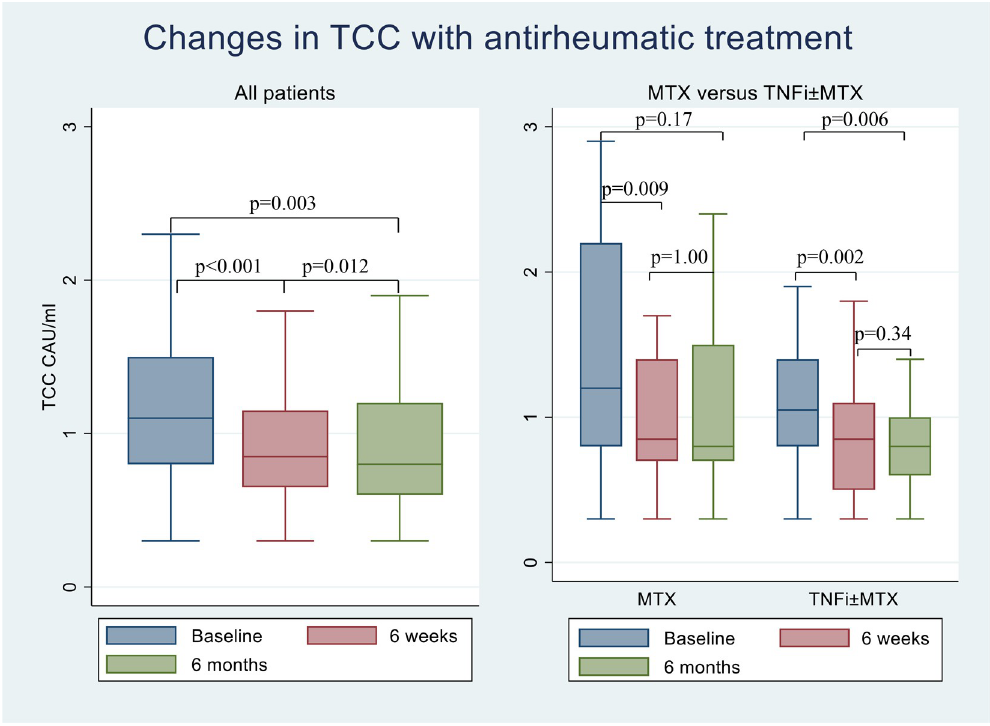
Fig 2. Changes in TCC with MTX monotherapy and TNFi ± MTX treatment. Boxplot displaying the difference in TCC at baseline and post-treatment with MTX monotherapy and TNFi ± MTX for the whole population. The lines inside the boxes show the median, bottom and top of the box represent 25 and 75 percentile and whiskers represent minimum and maximum values. Values are given in median. MTX: Methotrexate, TNFi: Tumor necrosis factor inhibitors, TCC: Soluble terminal complement